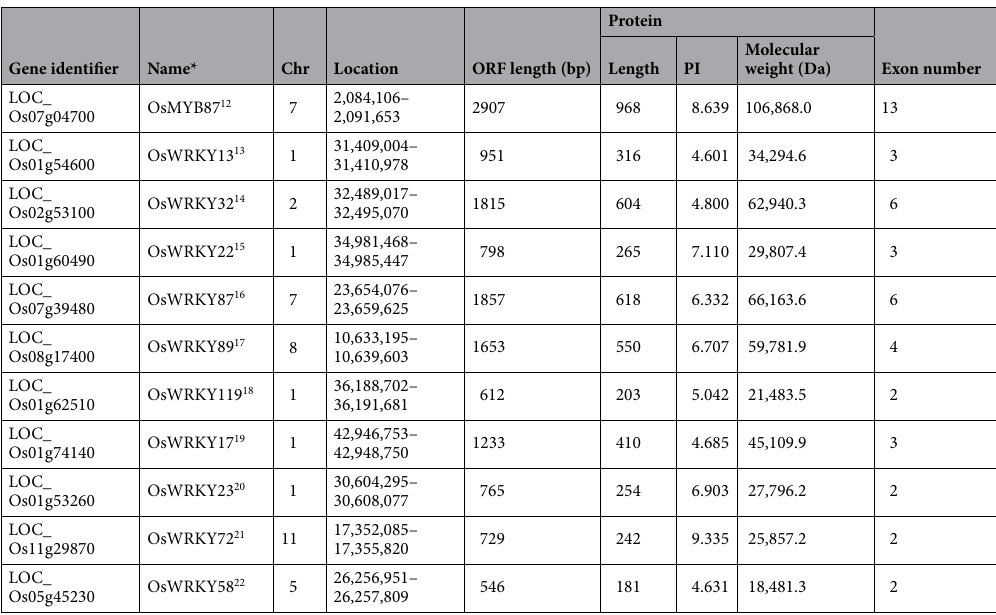
Table 1. Orthologous WRKY, MADS-box and MYB gene-pairs in Arabidopsis and rice. Each gene is described according to chromosome loci, open reading frame (ORF) length, properties of the encoding protein and exon number. *Similar superscript numbers in the name column represents orthologous gene